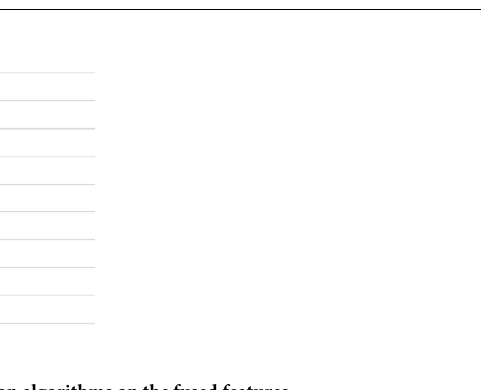
Fig 4. Performance results of different classification algorithms on the fused features.